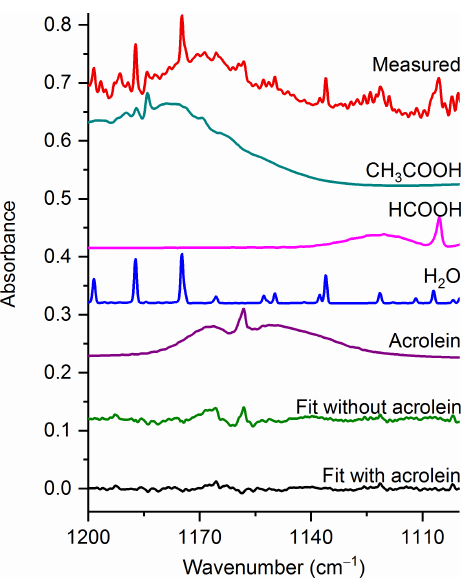
Figure 6. Measured spectrum and the individual spectral contribu- tions for the major components and associated residual with and without acrolein included in the fit. For clarity, the spectral contri- butions for furfural (C 4 H 3 OCHO), acetaldehyde, CH 4 and C 2 H 4 are not shown. All spectra are at 0.6cm − 1 resolution and have been offset for clarity. The calculated mixing ratio of acrolein in this mea- sured spectrum is 99.9 ppm.